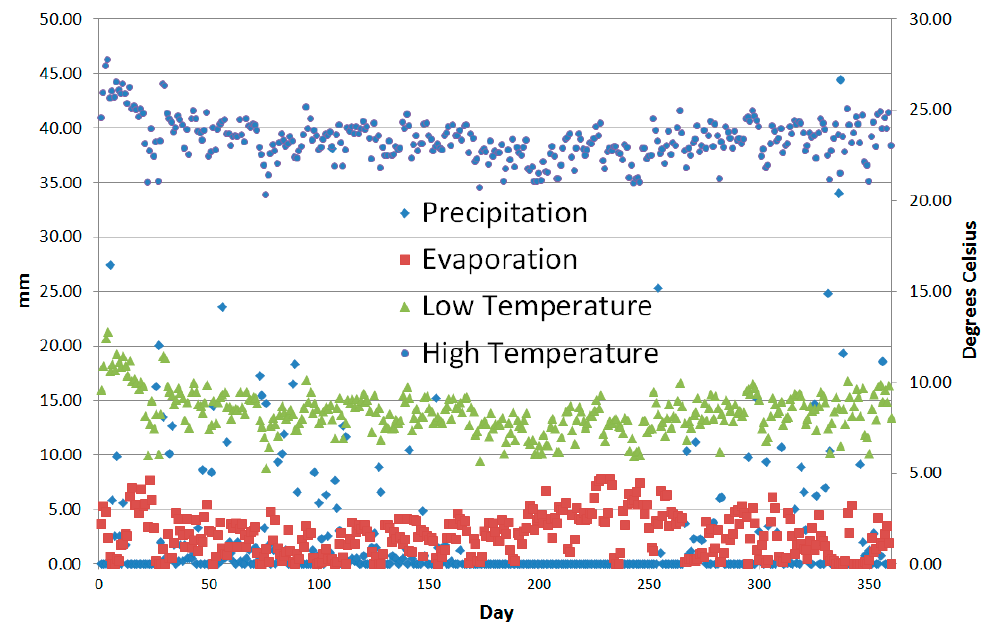
Figure 6. Meteorological data for 2-year simulation period.